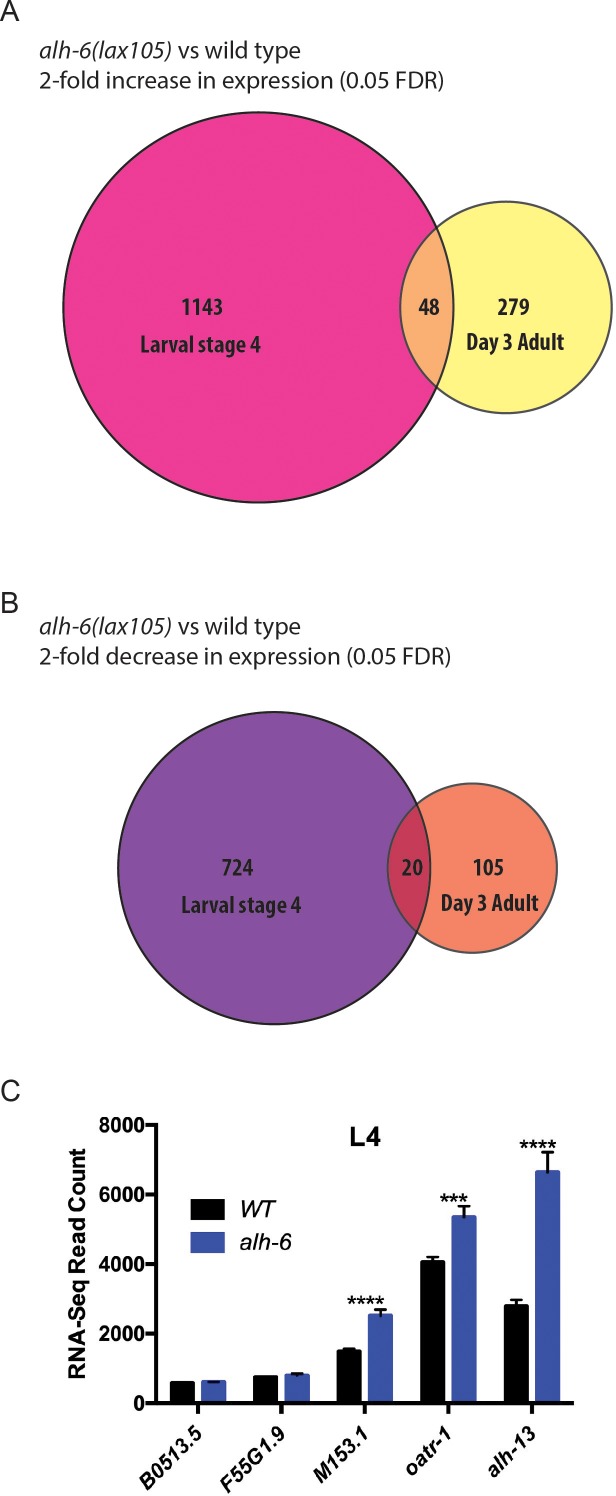
RNA-Sequencing data of WT and alh-6 hermaphrodites at L4 and day three adulthood.(A) Number of genes that are significantly upregulated in alh-6(lax105) compared to WT at L4 and Day three adult stages. (B) Number of genes that are significantly downregulated in alh-6(lax105) compared to WT at L4 and Day three adult stages. FDR = 0.05. (C) alh-6 mutants display increased expression of metabolic enzymes to reduce P5C levels. All studies performed in biological triplicate; refer to Supplementary file 1 for n for each comparison.